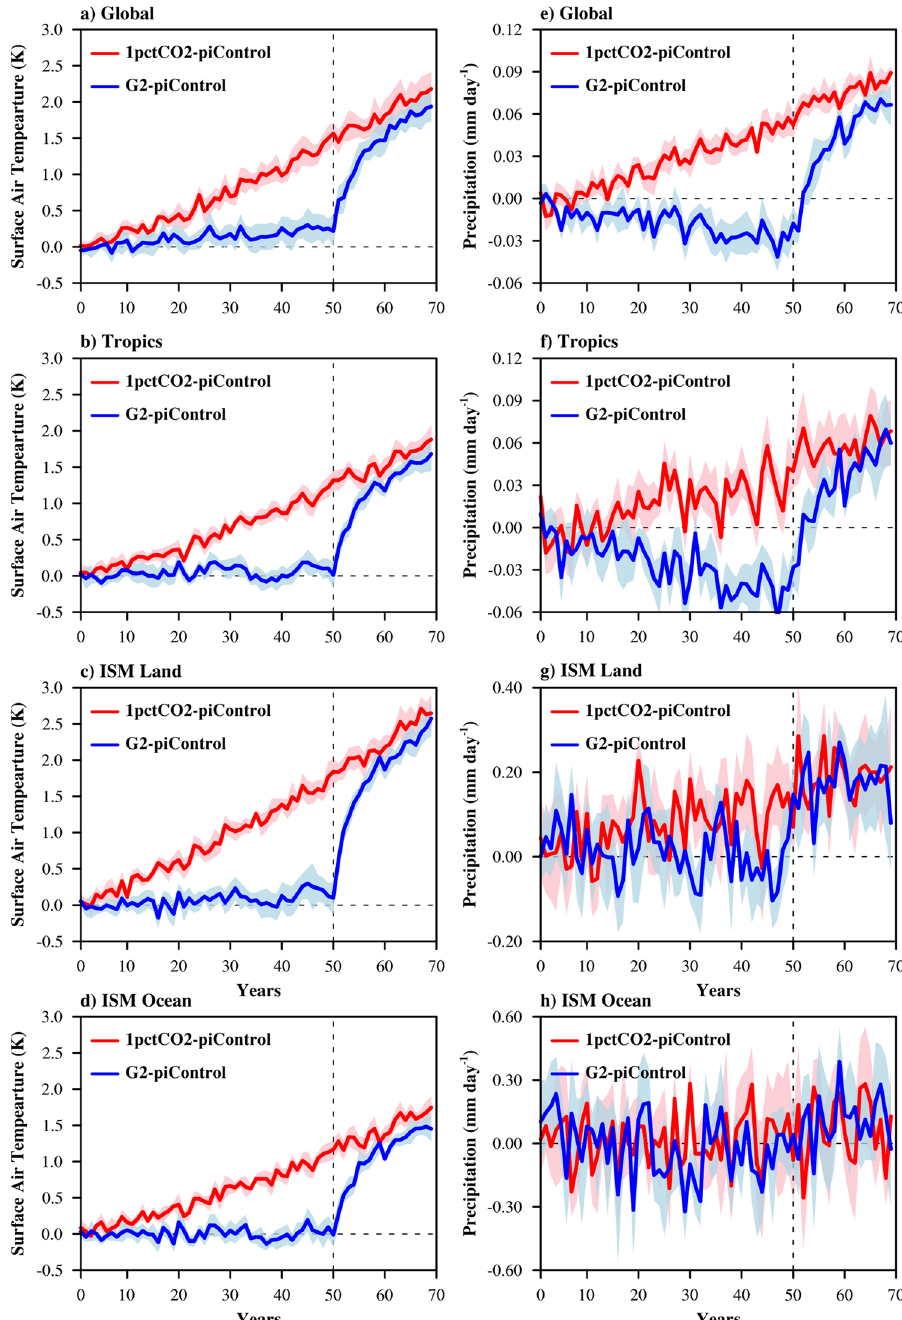
Figure 1. Changes in surface air temperature (°C, left column) and precipitation (mm/day, right column) for 1pctCO2 (red line) and G2 (blue line) simulations relative to the piControl condition for the globe (top row, JJA mean), tropics (middle row, JJA mean), and Indian monsoon region (bottom row, JJAS mean). Lines show the multi-model mean and the shadings show the intermodel standard deviation. The dashed vertical line shows the time of termination of geoengineering in the G2